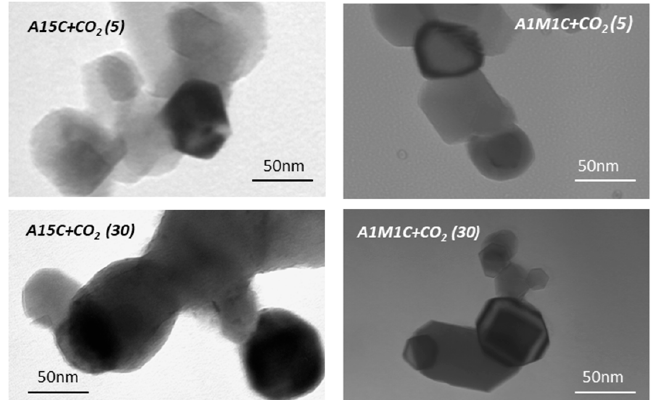
Figure 6. TG (solid lines) and DTA (dotted line): (left) curves for calcite A15, calcite A15 after 5 cycles and calcite A15 after 30 cycles of calcination—CO 2 flow of 20 mL min − 1 (1 h)—calcination in air a 900 ◦ C; (right) curves for calcite A1M1, calcite A1M1 after 5 cycles and calcite A1M1 after 30 cycles of calcination—CO 2 flow of 20 mL min − 1 (1 h)—calcination in air a 900 ◦ C.